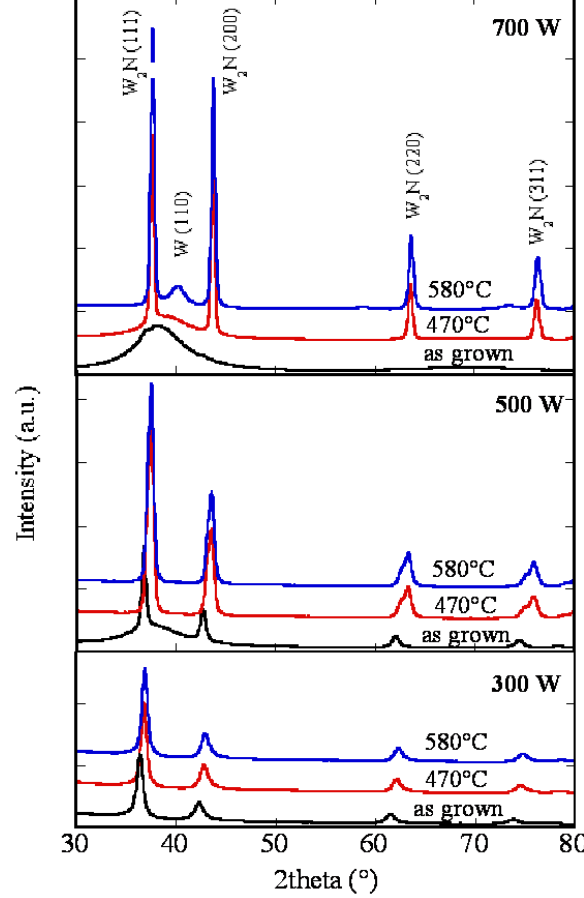
Figure 3. XRD patterns of different WN x films before and after annealing.